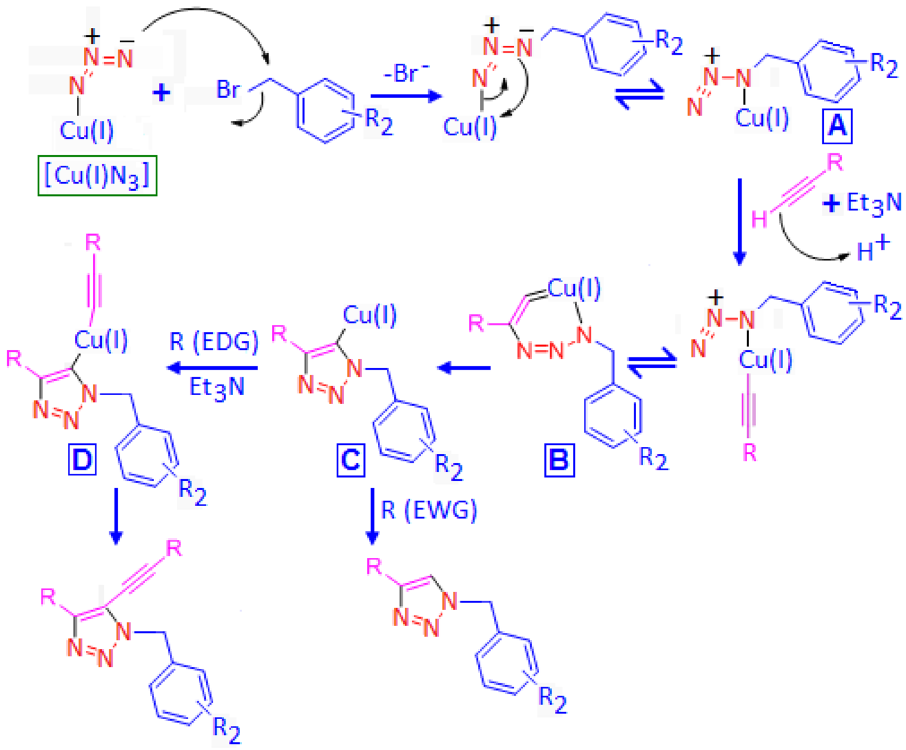
Figure 3. Proposed mechanism for CANP mediated azide-alkyne cyclo addition reaction using alkyne molecule with electron donating group (EDG) and electron withdrawing group